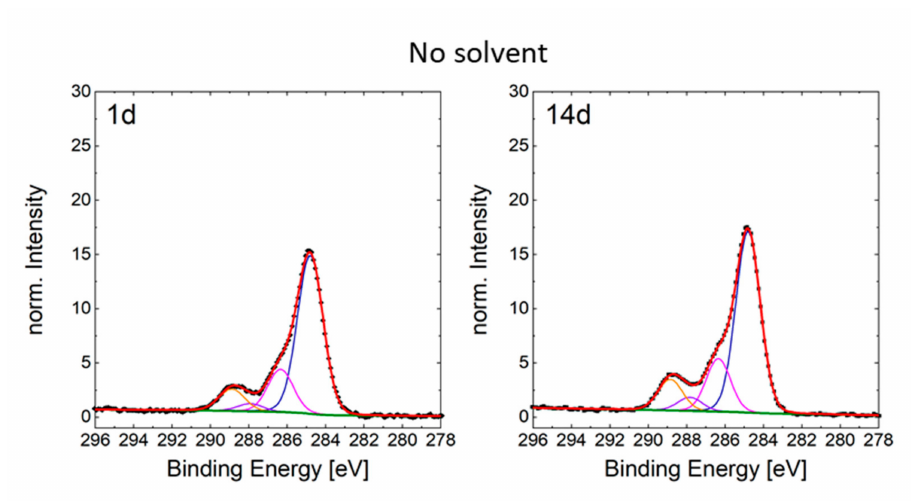
Figure A6. C 1s spectra of structured sample 1 and 14 days after preparation. No solvent was used for